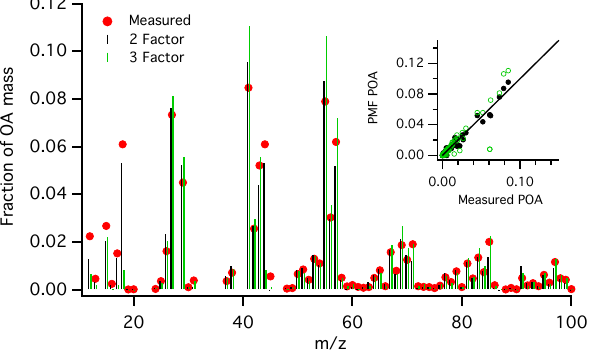
Figure 8. Comparison of the measured POA for experiment CFM56-2 (symbols) to the POA factors determined by 2-factor (black) and 3-factor (green) PMF solutions. The inset shows scatter plots of the mass spectra, and the black line is the 1 : 1 line. There is better agreement between the measured POA and the 2-factor so- lution for this experiment.